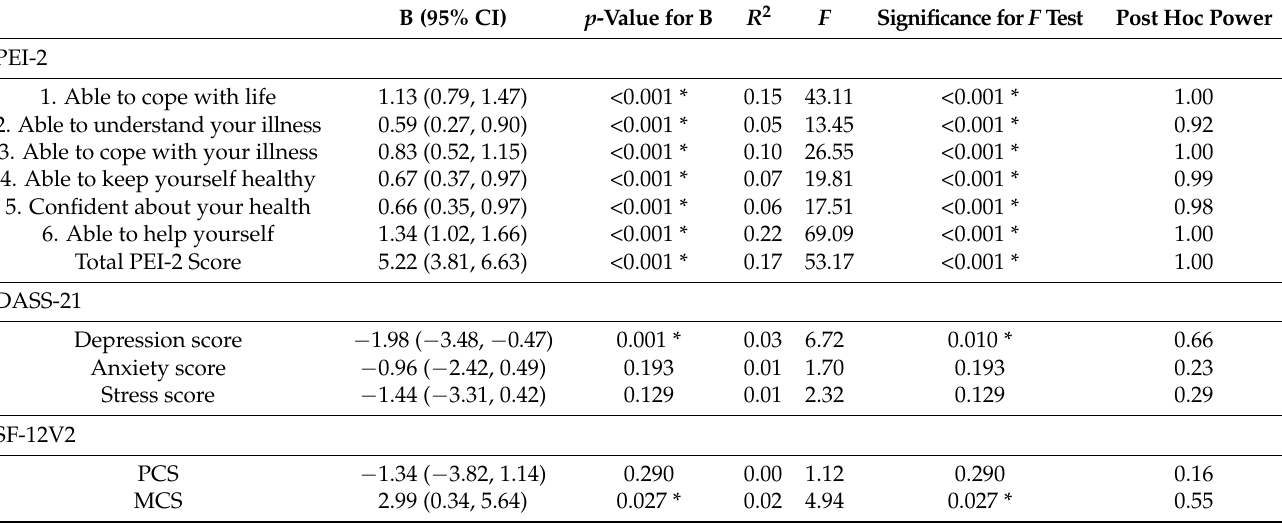
Table 3. Association between health empowerment program participation and changes in outcomes at 5 year follow-up after propensity score